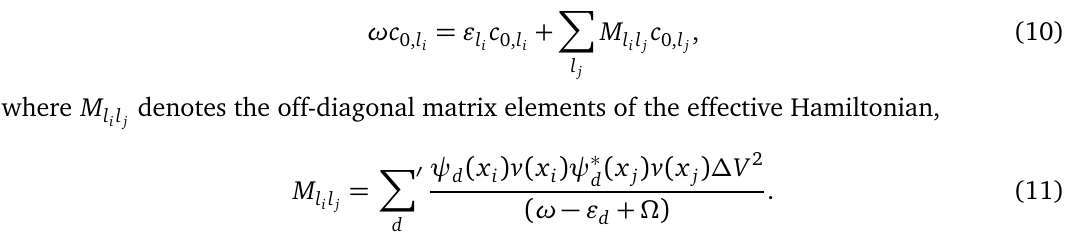
Figure 7: Schematic quasienergy spectrum of the undriven two-leg Shirley ladder. The gray shaded regions highlights the window of states which hybridize between the two legs when the driving is turned